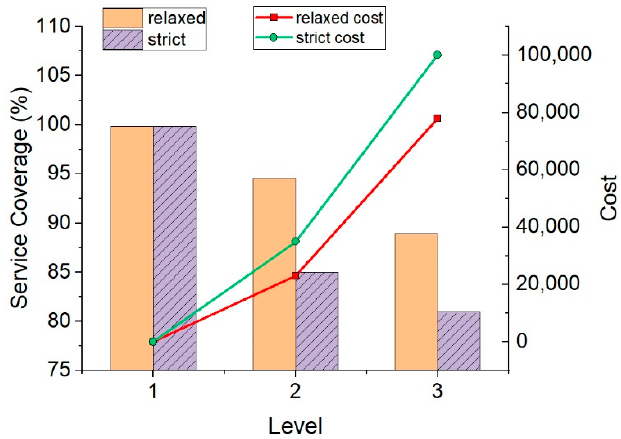
Figure 15. Impact of inference strategy on structure.